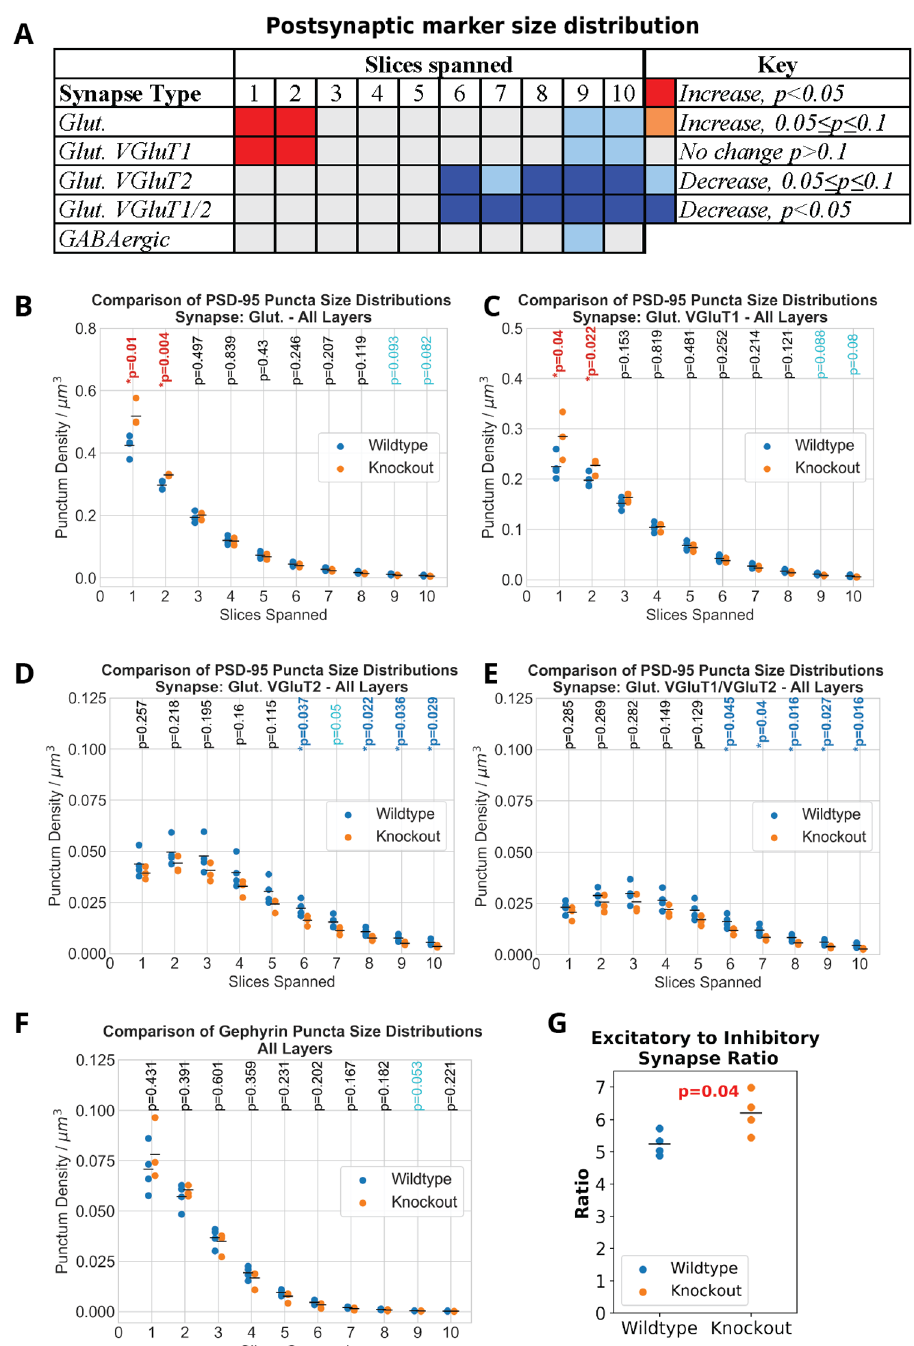
Figure 6. Postsynaptic marker size distributions. ( A ) Summary table showing the differences in the size distributions of PSD-95 puncta associated with synapses by type. The main takeaway is that for excitatory synapses overall, there is an increase in the number of small PSD-95 puncta in FMR1 knockout mice while there is a decrease in the number of very large PSD-95 puncta associated with synapses containing VGluT2. ( B – E ) Plots showing the distribution of PSD-95 puncta for both wild-type and knockout mice. ( F ) Size distribution of gephyrin puncta associated with inhibitory synapses. ( G ) Plot shows the significant increase in the ratio of excitatory to inhibitory synapses in knockout